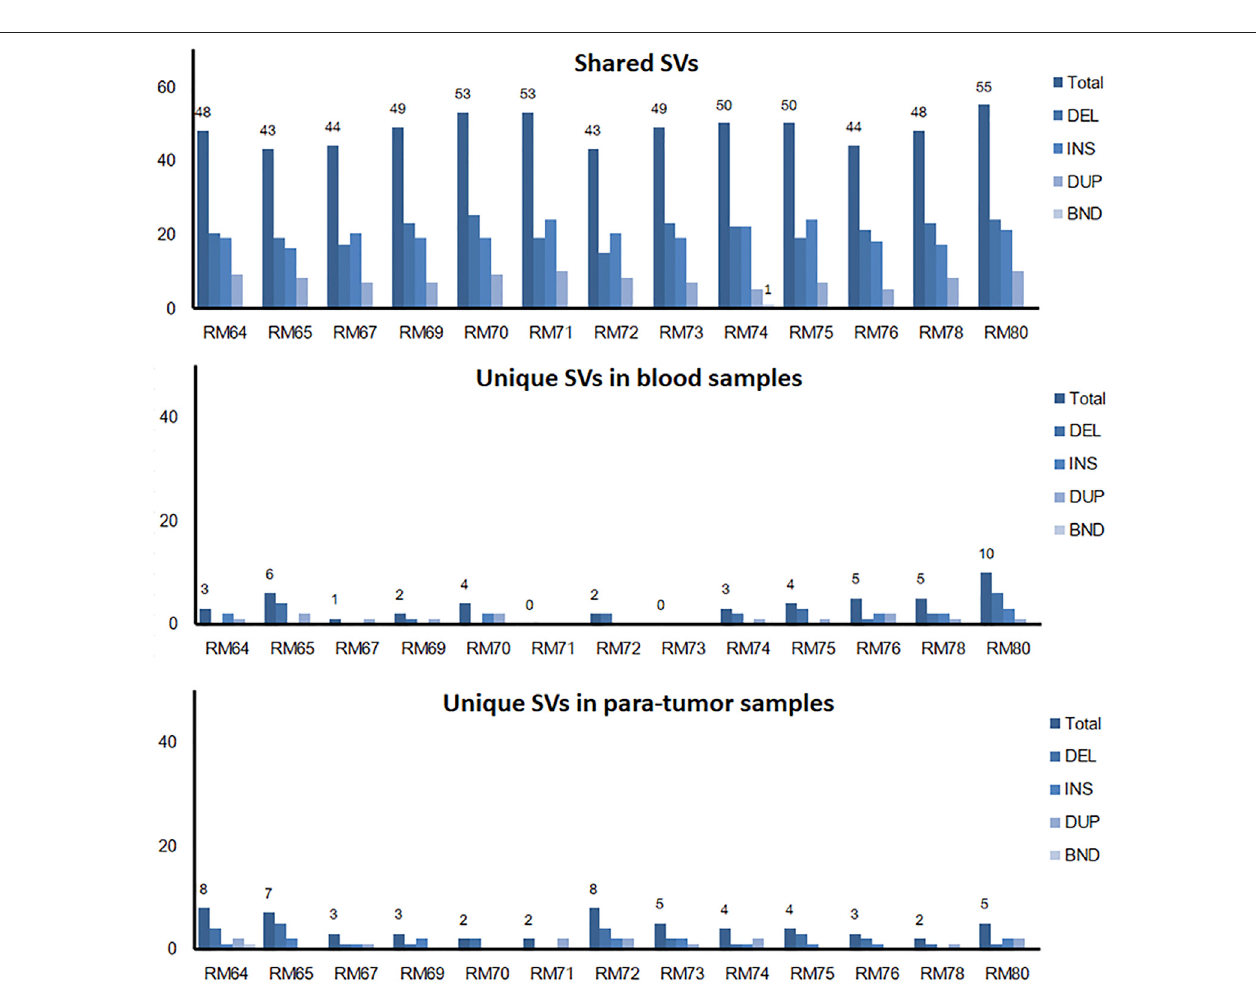
FIGURE 4 | Shared and unique SVs in para-tumor tissue and blood samples. A comparison of shared and unique SVs between two kinds of samples. Numbers above individual bars showed the number of total SVs. DEL, deletion; INS, insertion; DUP, duplication; and BND, Breakpoint notation. Most SVs were found in both tissues, while a few unique SVs were only observed in one of the